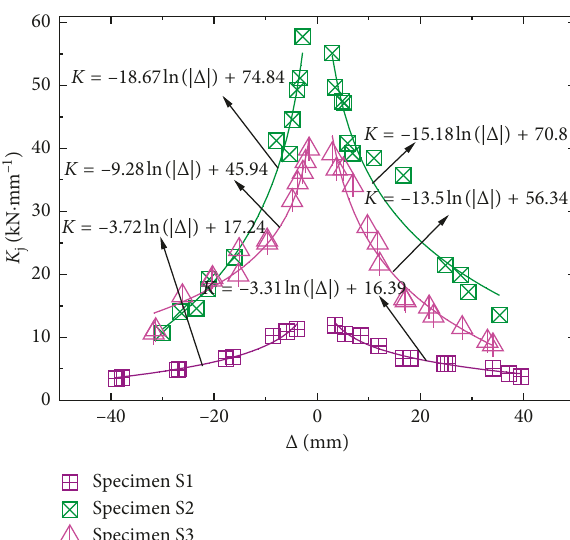
Figure 11: Stiffness degradation